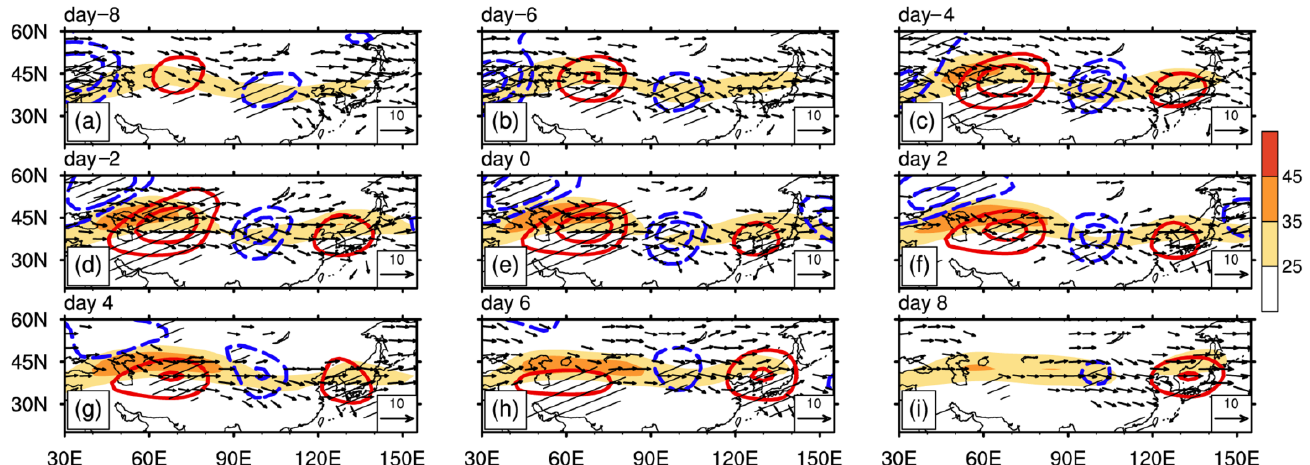
Figure 3. Composite 200 hPa geopotential height anomalies (contours are from − 80 to 80 gpm with interval of 40 gpm, red for positive and blue for negative), the zonal wind speed (shading; units: m s − 1 ), and wave-activity flux (vector; units: m 2 s –2 ) of SRP+ events from day –8 to day 8 ( a – i ) in Table 1. The slash shadings denote that the height anomalies are statistically significant at the 0.05 confidence level. The numbers at the top-left corner above each panel represent the days leading (negative) and lagging (positive) the peak date of the SRP+ events. Wave fluxes smaller than 4 m 2 s –2 are not plotted.